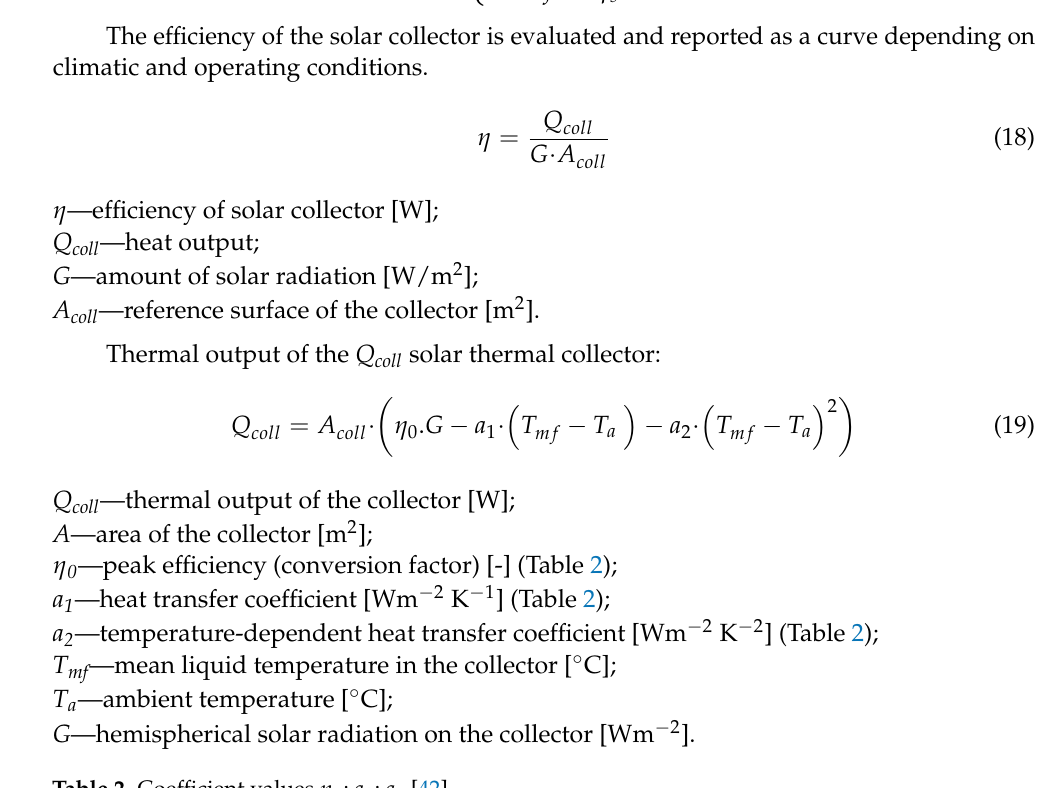
Table 2. Coefficient values η 0 ; a 1 ; a 2